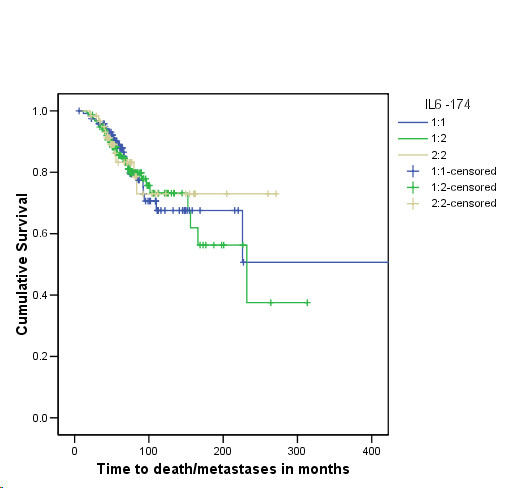
shows the time to death or metastases in invasive breast cancer for the genotypes of the IL6 -174 polymorphism. Log Rank test statistic = 0.16; df = 2; p = 0.92 (n = 333).